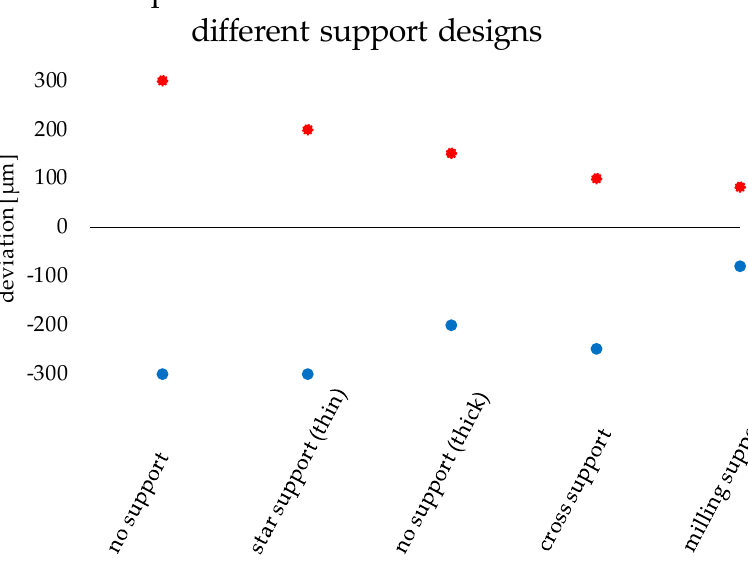
Figure 9. Comparison of dimensional deviation of the different support designs.